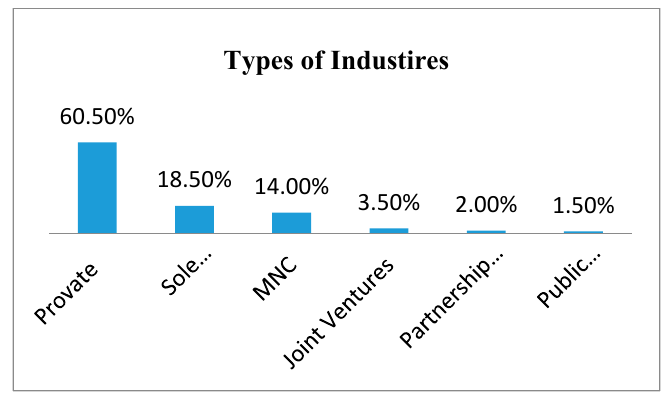
Figure 5. Types of industries used as a sample.